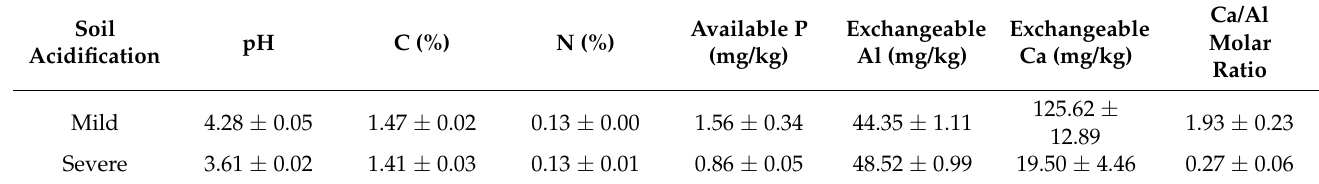
Table 1. Chemical properties of the soil sample used in the